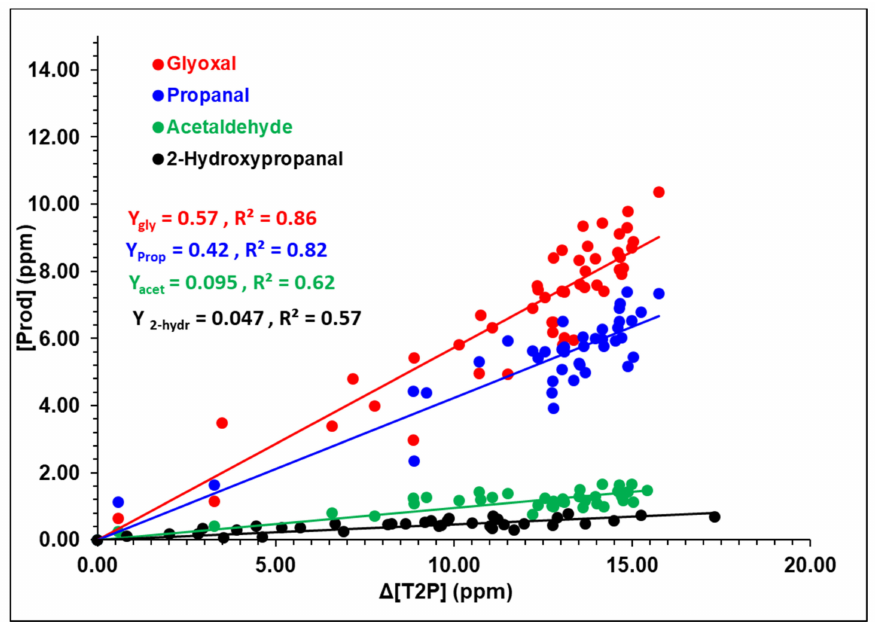
Figure 3. Products yield Yx plots obtained for the T2P ozonolysis with cyclohexane as an OH scavenger in RASC-Reims with x = glyoxal (red), propanal (blue), acetaldehyde (green) and 2- hydroxypropanal (black).